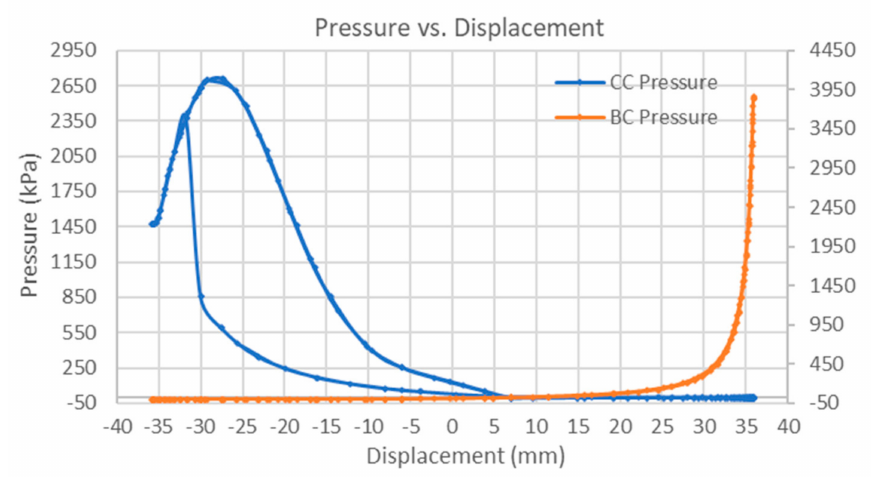
Figure 9. Operation with load: pressure vs. displacement profile for CF = 1.